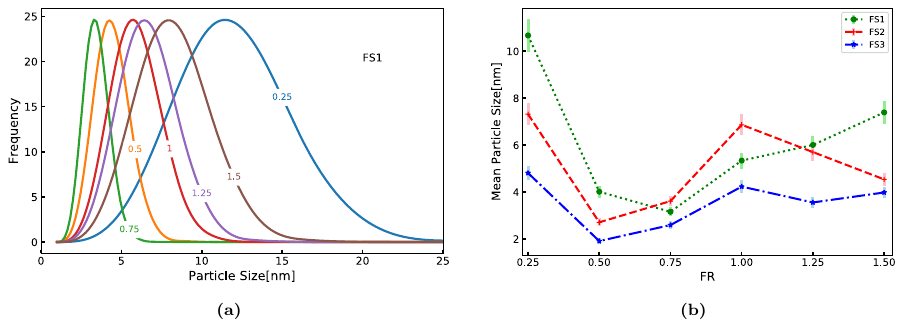
Figure 10. Characteristics of ceria PSDs predicted at the exit of the reactor: ( a ) PSD for different flow ratios in FS1, and ( b ) mean particle size and standard deviation of PSD (shown as bars around the mean) predicted at the exit.